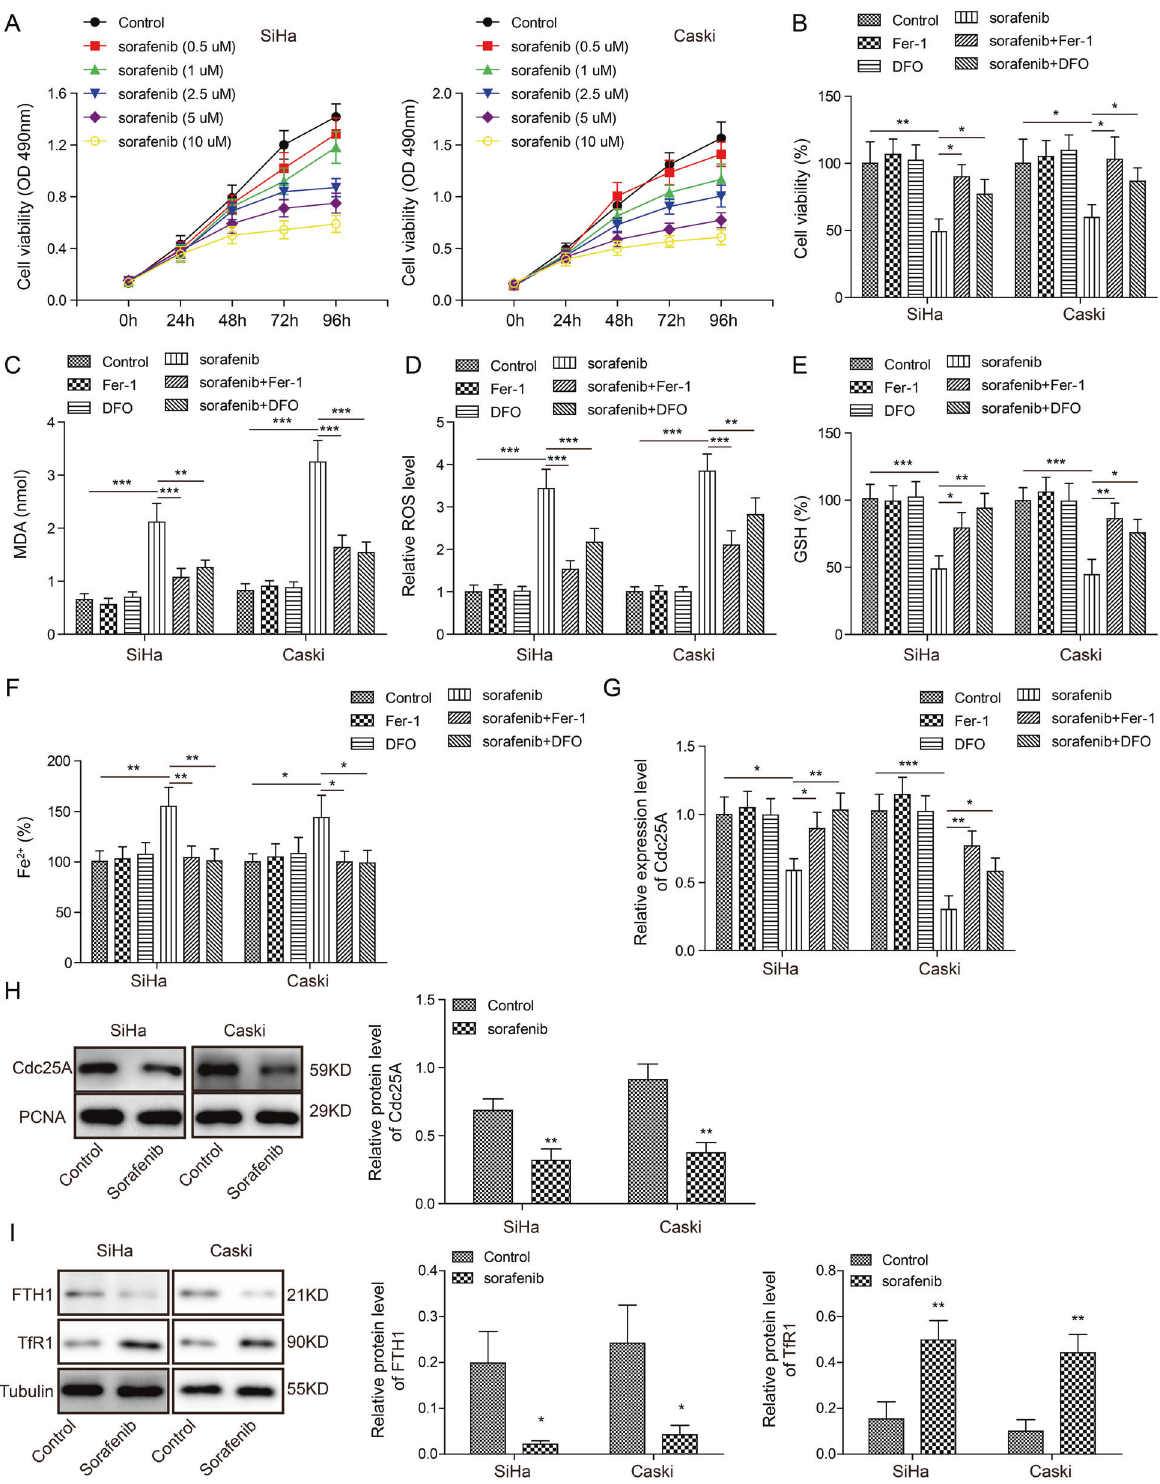
Fig. 2 Cdc25A was reduced during sorafenib-induced ferroptosis of human cervical cancer cells. A The MTT assay to analyse cell viability following sorafenib treatment with different concentrations. B The MTT assay to analyse cell viability upon various drug treatments. C Cellular MDA levels after drug treatment. D Cellular ROS levels after 48 h of drug treatment. E Cellular GSH levels after 48 h of drug treatment. F Cellular iron levels after 48 h of drug treatment. G and H Cdc25A mRNA ( G ) and protien levels ( H ) in cervical cancer cells following 48 h of sorafenib treatment. I Protein levels of FTH1 and TfR1 in cervical cancer cells following 48 h of sorafenib treatment. Each experiment was repeated three times. * P < 0.05; ** P < 0.01; *** P < 0.001.